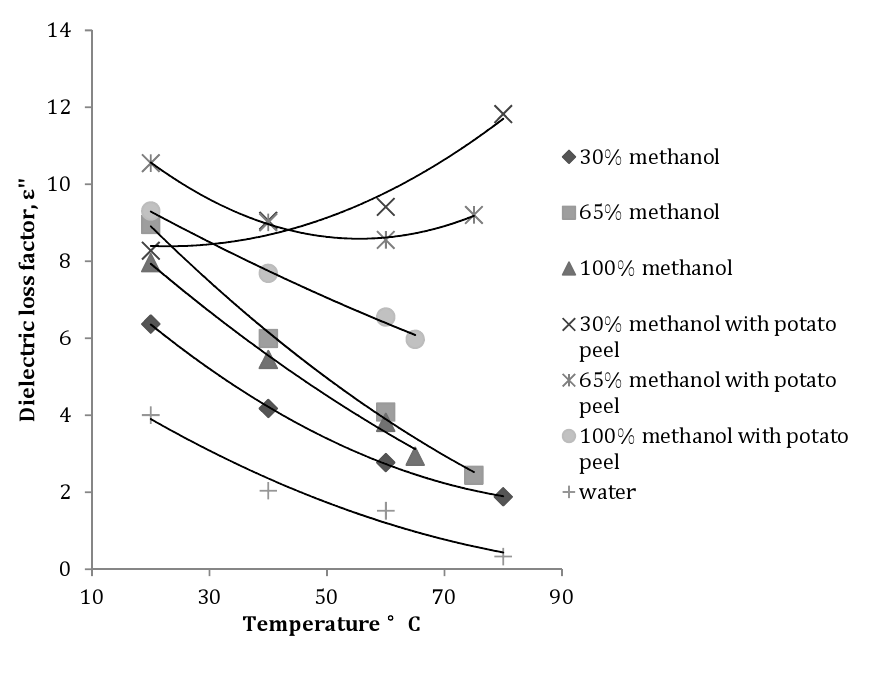
Figure 5. Variation in dielectric loss factor of a methanol-water mixture with and without potato peel at 915 MHz (Source: Adapted from